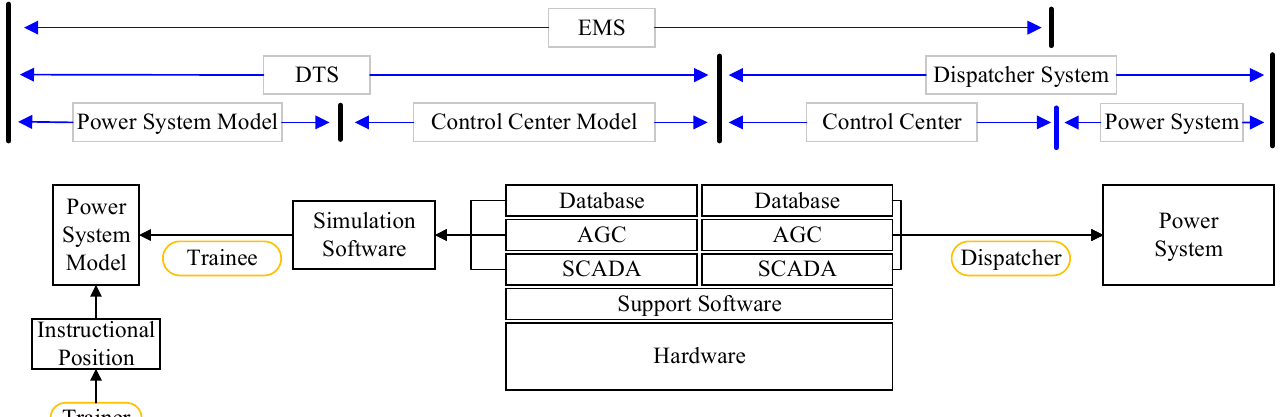
Figure 1. Structure of a DTS (Reproduced with permission of Ref. [28]).